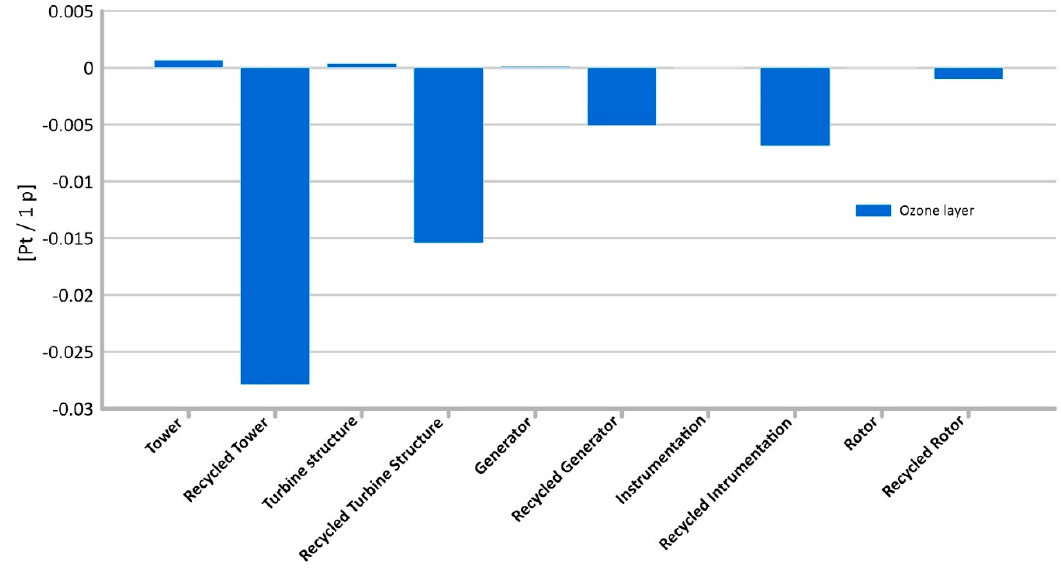
Figure 11. Results of grouping and weighting—ozone layer.